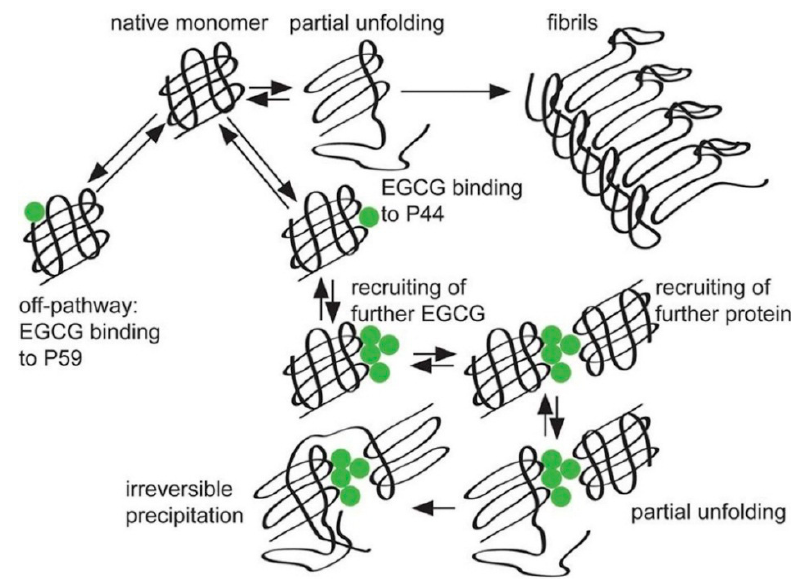
Figure 7. CMDA of the binding of EGCG with serum immunoglobulin light chains to cause fibril formation. A filled circle represents an EGCG molecule. Data are reproduced from Hora et al. [71]